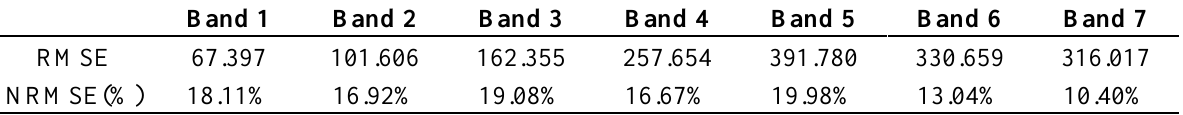
Table 2. Overall RMSE and NRMSE from five-fold cross validation for each band